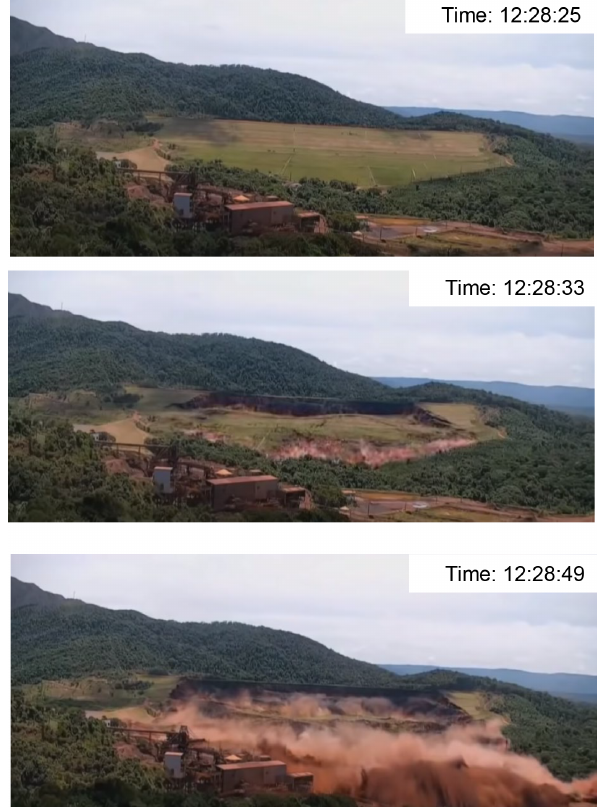
Figure 3. Stills from the YouTube video of the Brumadinho dam failure (source: YouTube (2020), provided to the Brumadinho dam investigation by the National Mining Agency of